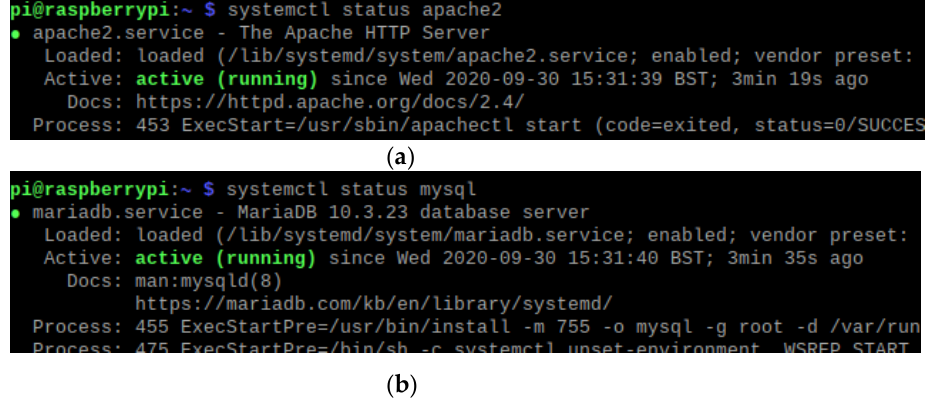
Figure 8. ( a ) MySQL service running on Raspberry Pi. ( b ) Apache2 service running on Raspberry Pi.